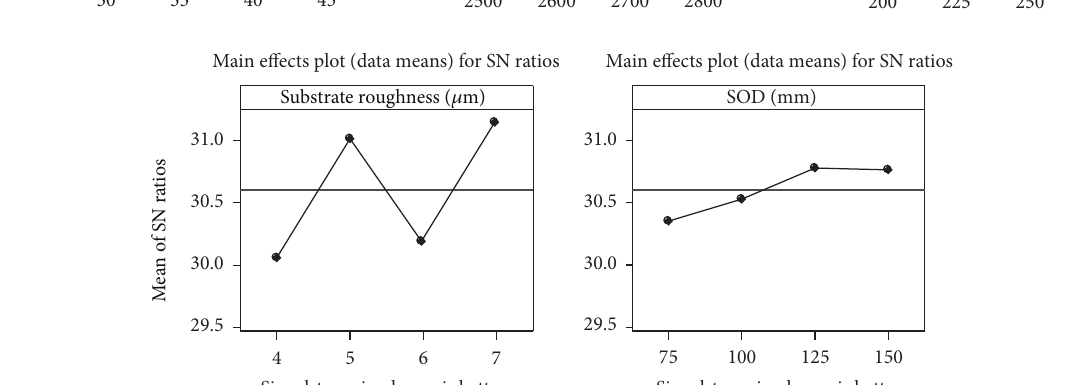
Figure 7: Main effect plot for S/N ratio of individual control